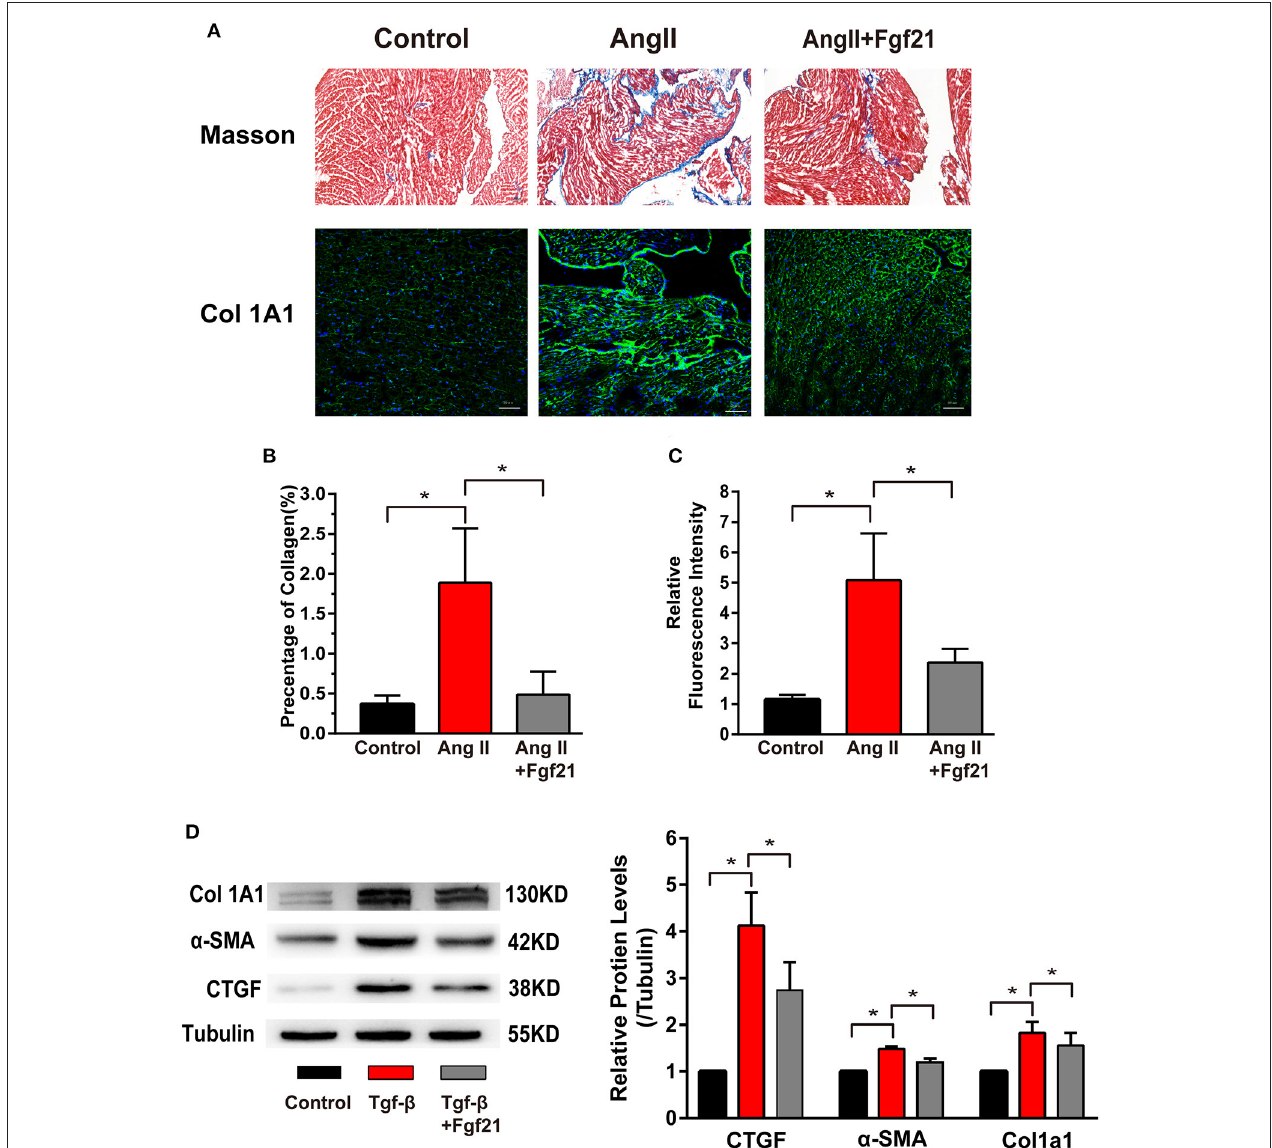
FIGURE 4 | Effects of Fgf21 on atrial fibrosis. (A) Representative photomicrographs of atria slices from each group mouse stained with Masson and immunohistochemistry of collagen I. Scale bar indicates 100/50 µ m. (B) Summary of the total collagen volume in the atria of each group mouse. (C) Summary of the relative fluorescence intensity of collagen I in the atria of each group mouse. (D) The expression of Col 1A1, α -SMA, and CTGF at protein levels in each group of fibroblasts. * p < 0.05, n = 6 mice per group. with SPSS 21.0 (SPSS, Inc., Chicago, IL, USA). The p -values were two-sided and a p < 0.05 was considered statistically